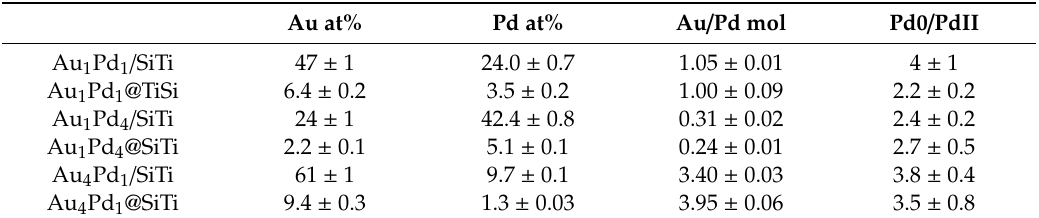
Table 2. X-ray photoelectron spectroscopy (XPS) analysis of the supported and embedded catalysts. Au